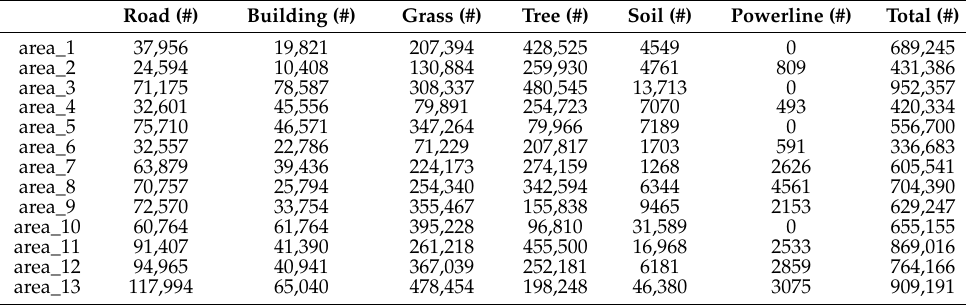
Table 2. Specifications of the Titan system (# represents the number of the points). Road (#) Grass